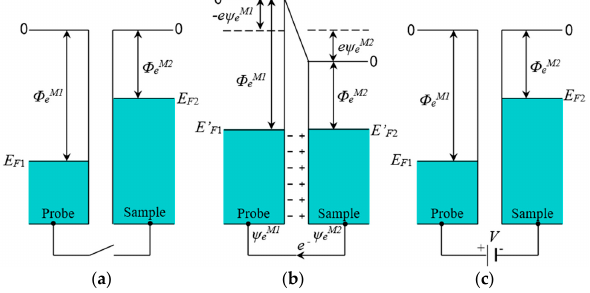
Figure 7. Schematic diagram of the scanning Kelvin probe microscope in ( a ) noncontact mode, ( b ) contact mode, and ( c ) test mode.